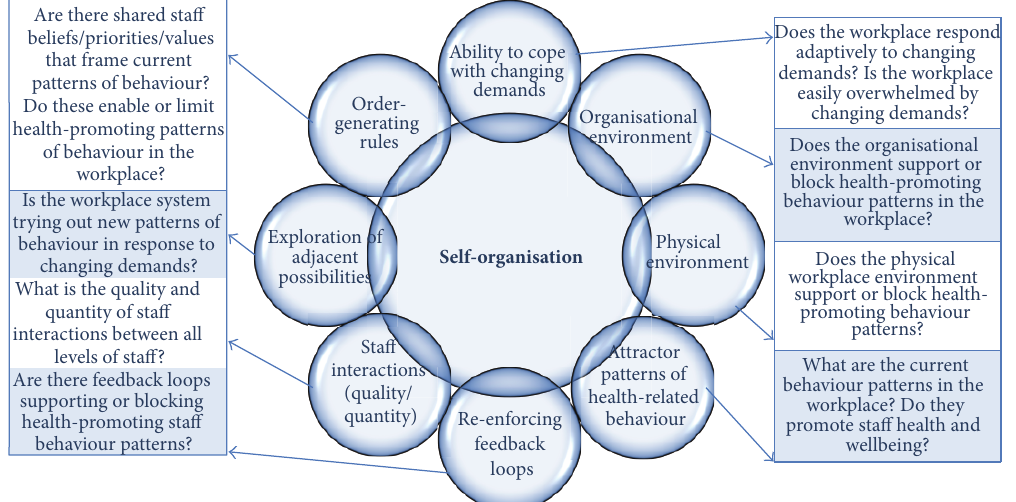
Figure 1: The Workplace of Well-being (WoW) framework developed from the principles of complex adaptive system theory guides exploration of eight interrelated workplace characteristics contributing to the ability of a workplace system to self-organise into more health- promoting patterns of